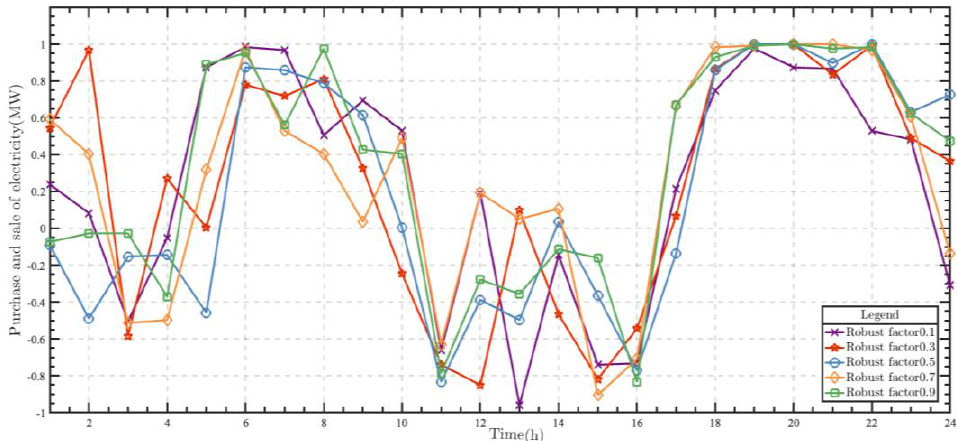
Figure 11. Robust decisions for DERA along with the robust factors.